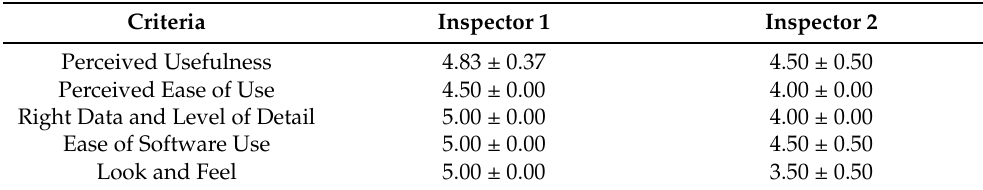
Table 5. Mean and standard deviations of the quantitatively measurable criteria of the TAM and TIF questionnaire, presented to quality control inspectors for validation of the information visualization module.